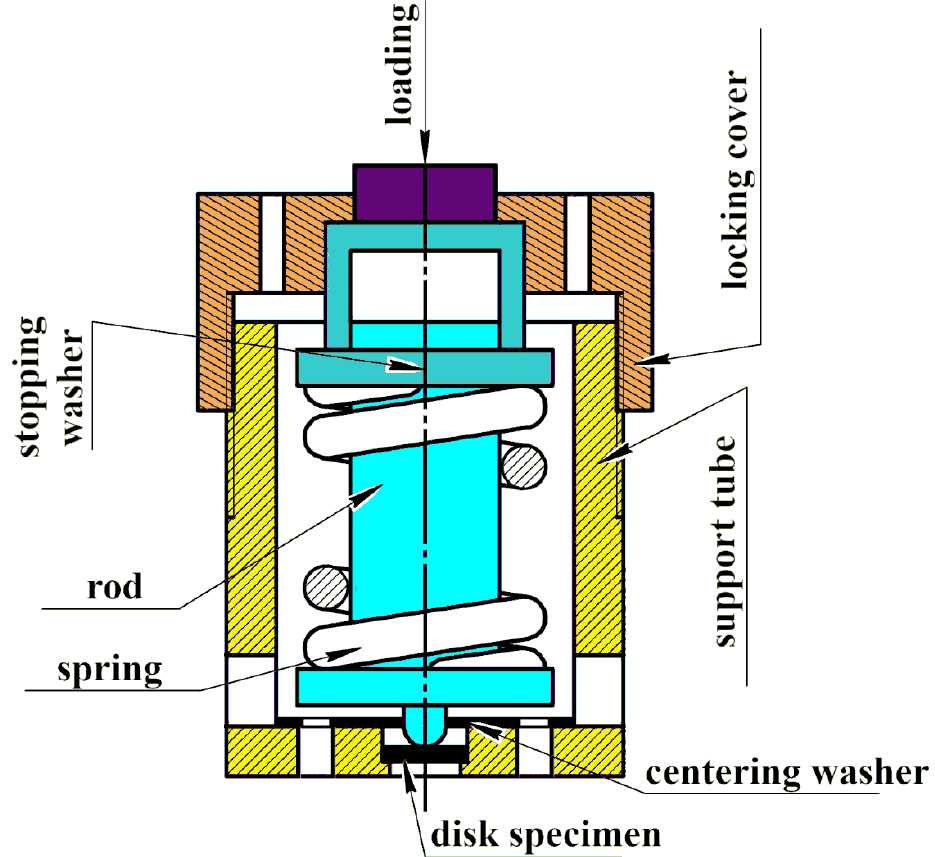
Figure 3. The loading device scheme for autoclave tests of disk specimens.